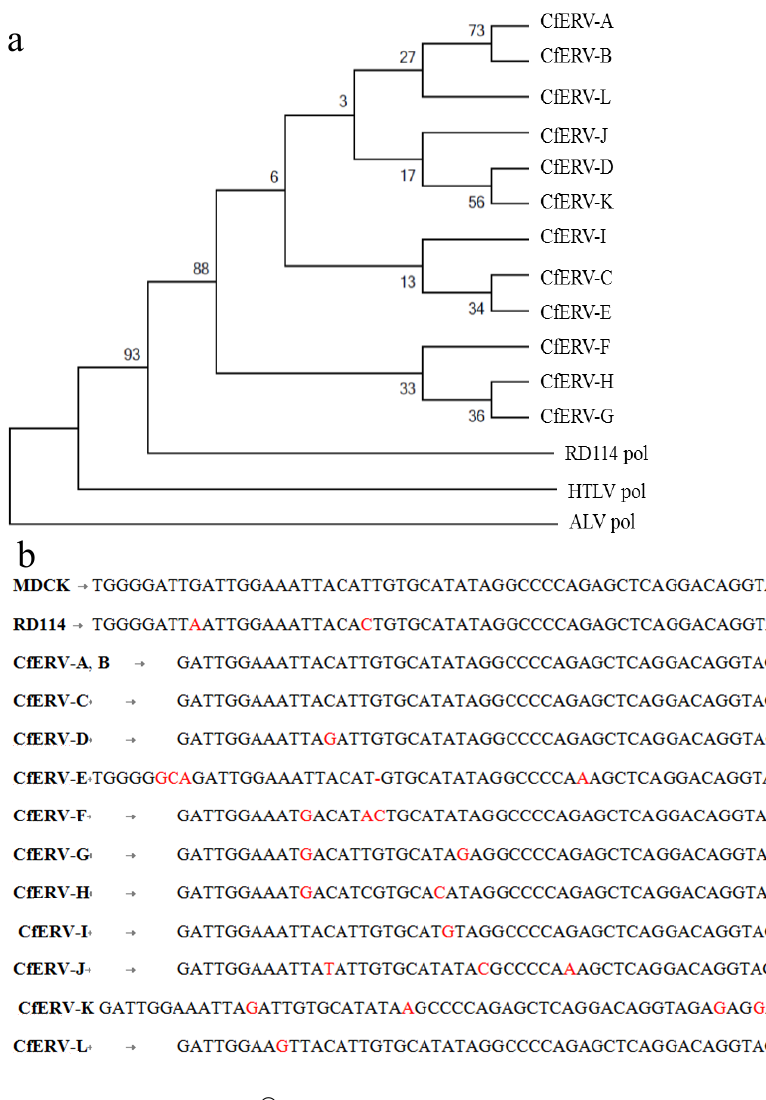
Figure 3. Molecular phylogenetic analysis and nucleotide sequence comparison of RD114-like CfERVs pol region 3. ( a ) A maximum likelihood tree based on the Kimura 2-parameter model was constructed using a conserved region of the pol region from BAC clones A–L (see Figure 2b) and distant homologs, HTLV-1 and ALV [34]. The bootstrap consensus tree inferred from 1000 replicates [35]. The percentage of replicate trees in which the associated taxa clustered together in the bootstrap test (1000 replicates) is shown next to the branches [35]. The analysis involved 15 nucleotide sequences. Codon positions included were 1st + 2nd + 3rd + Noncoding. All positions containing gaps and missing data were eliminated. There were a total of 134 positions in the final data set. Sequence MUSCLE alignment and evolutionary analyses were conducted in MEGA5 [36]; ( b ) Nucleotide sequence comparison of the MDCK74 sequence with the analogous region in RD114 virus and CfERVs is shown. Nucleotide differences are indicated in